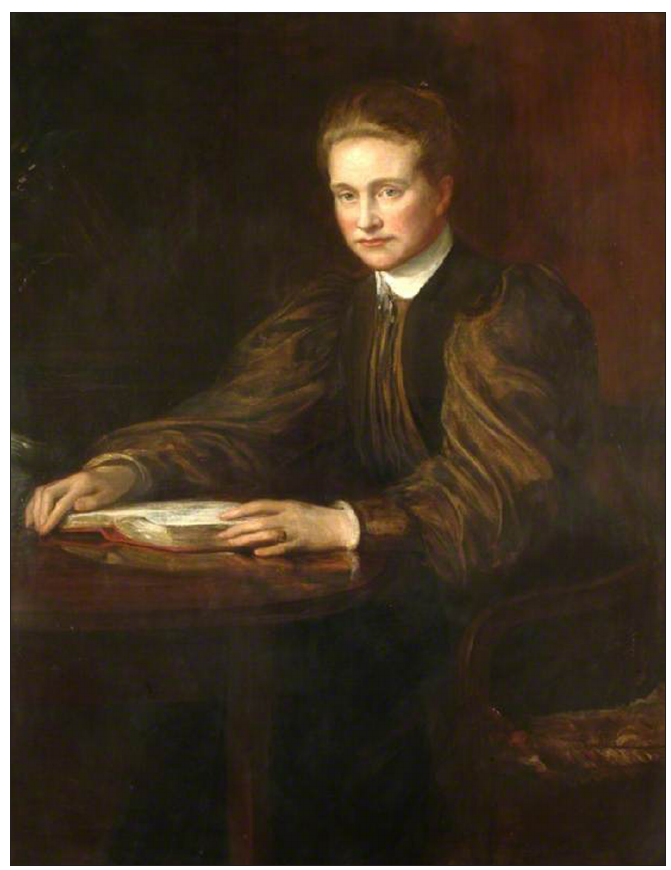
Fig. 1 : Theodore Blake Wirgman, Dame Millicent Fawcett , probably 1898, oil on canvas, 111.2 × 86.5 cm, Royal Holloway, University of London,